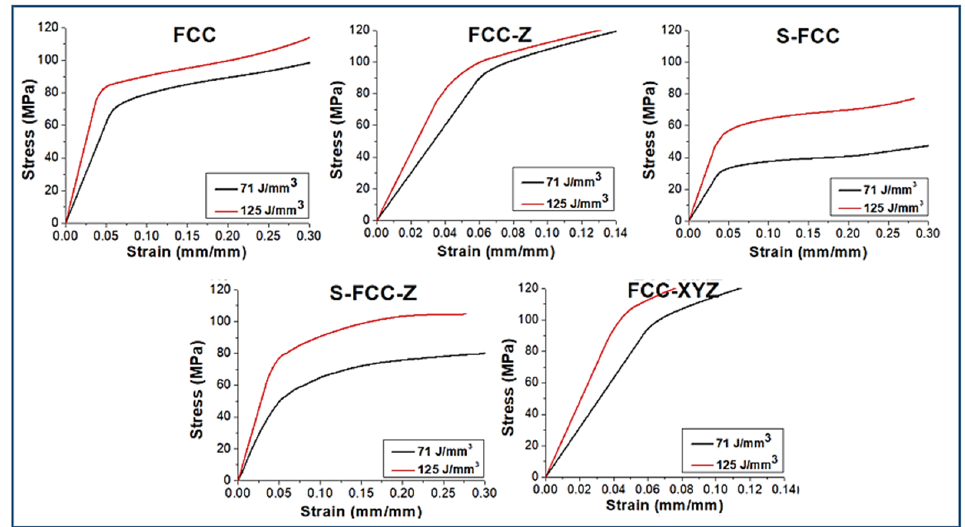
Figure 14. The comparison of flexural stress–strain curve of FCC-based lattices affected by laser energy densities.